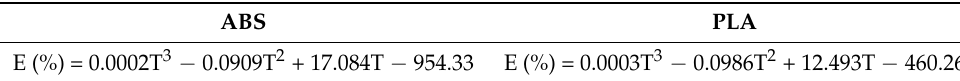
Table 10. Mould effectiveness as a function of annealing